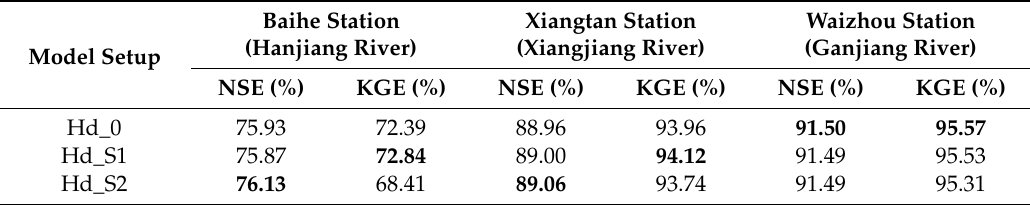
Table 4. Model performance, in terms of NSE and KGE, for the calibration period. The bold values indicate the best